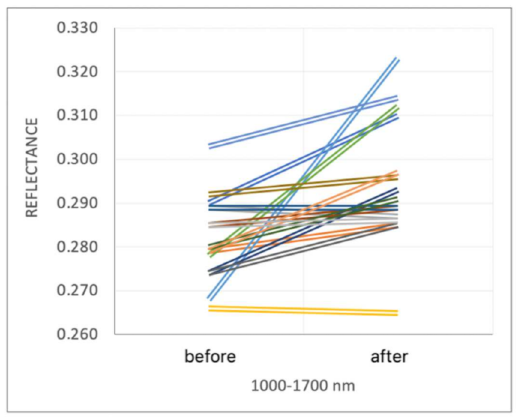
Figure 11. Average results of 3 reflectance measurements at a wavelength of 1000–1700 nm in every woman undergoing microdermabrasion, before and after the procedure.